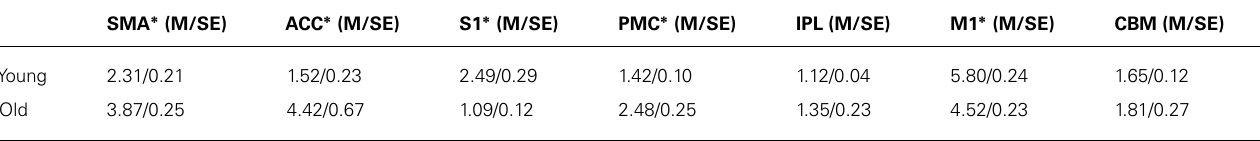
Table 2 | EC-to-CC ratio in the cortical areas and cerebellum in young and old